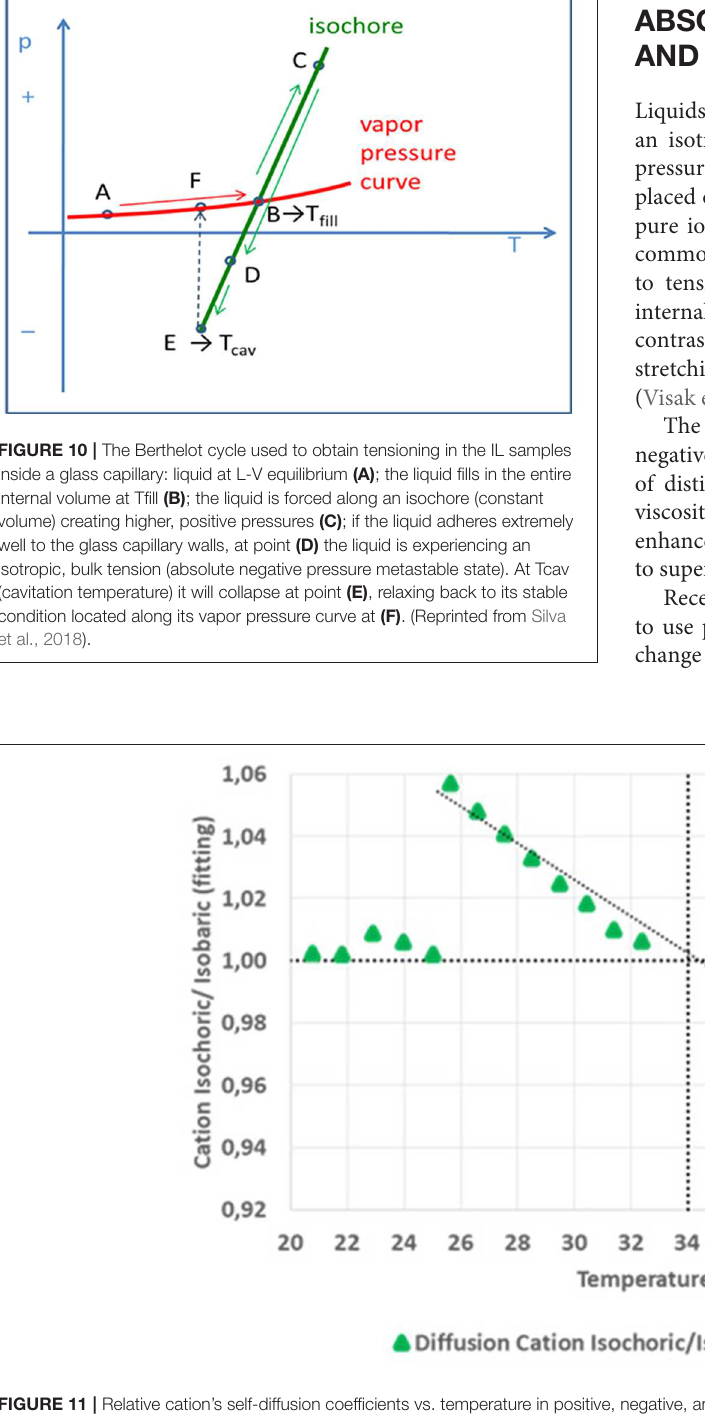
Frontiers in Chemistry |